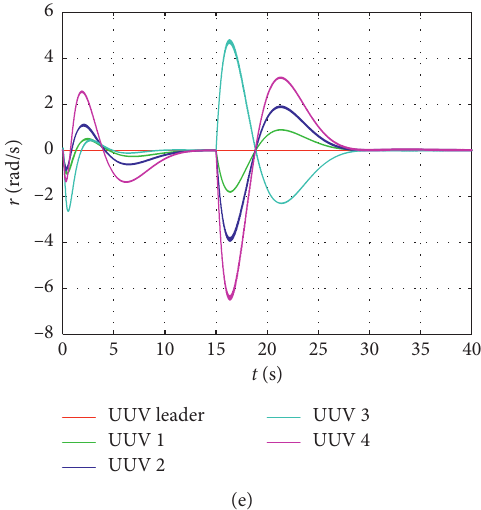
Figure 5: Velocity states of leader-following multi-UUVs with algorithm